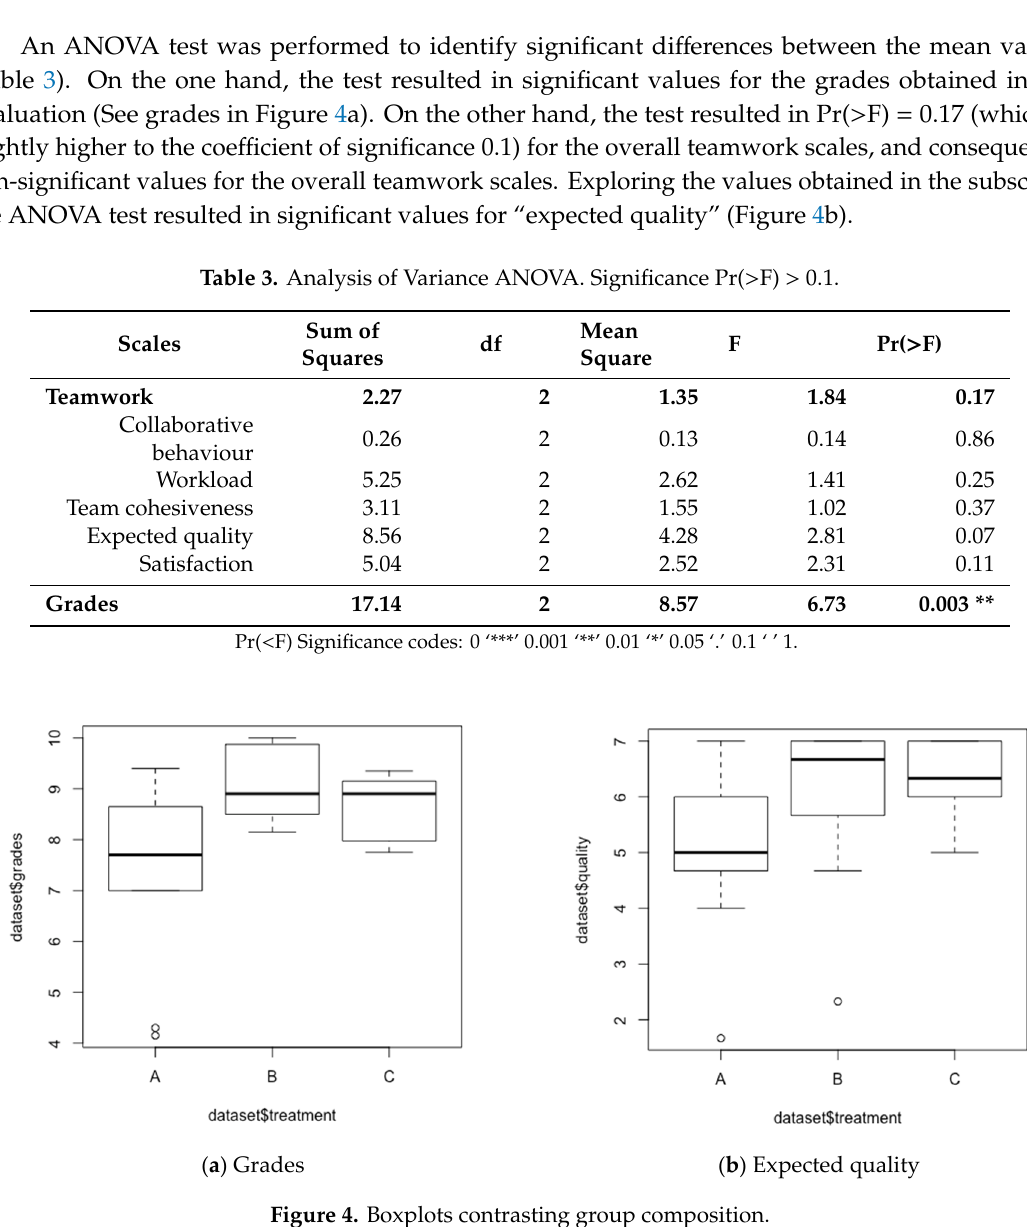
Table 3. Analysis of Variance ANOVA. Significance Pr( > F) > 0.1.